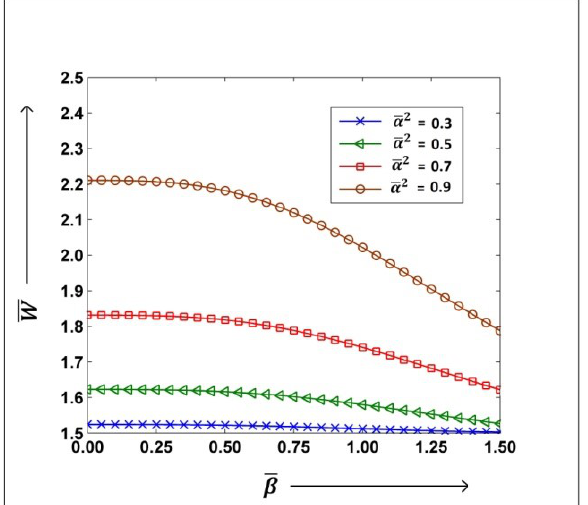
Fig. 11: Lifting force vs. Inlet-outlet ratio for different values of the . E = 1.2, ¯ µ * = r magnetic parameter at 1/¯ s = 1, ¯ α 2 = 0.25, ¯ β = 1.3, ¯ γ 2 = 1.2, P . E = 1.2 r